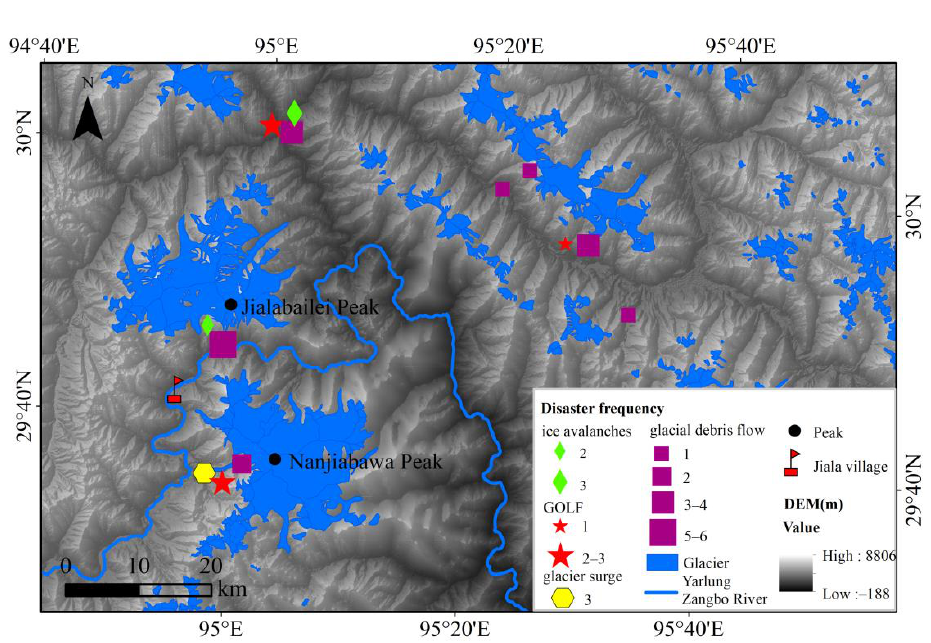
Figure 4. Frequency distributions of ice avalanches, glacial lake outburst floods (GOLF), glacier surges and glacial debris flows during the 1950s~2018 period.